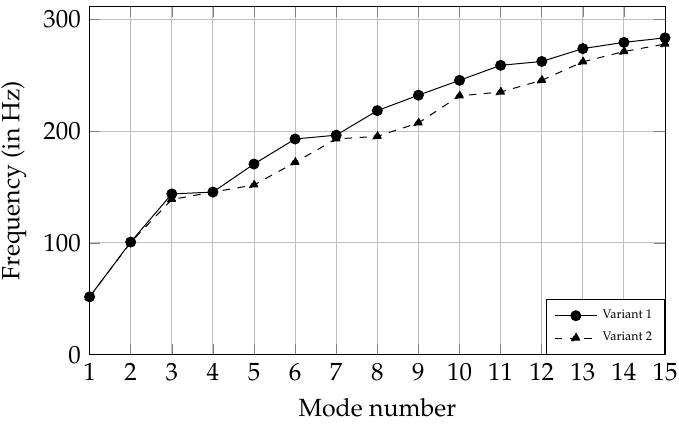
Figure 18. Results of influence of draft tube